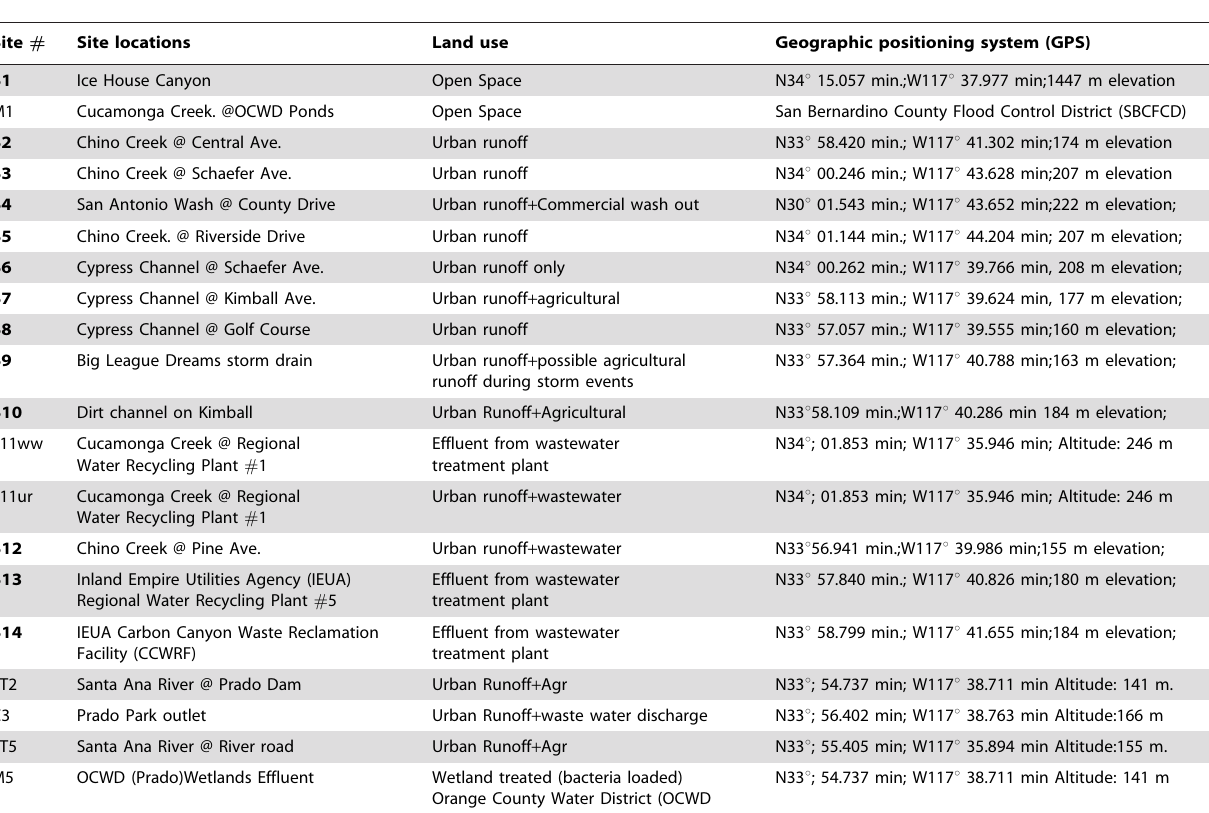
Table 1. Sampling Locations for MSAR Pathogen Source Evaluation